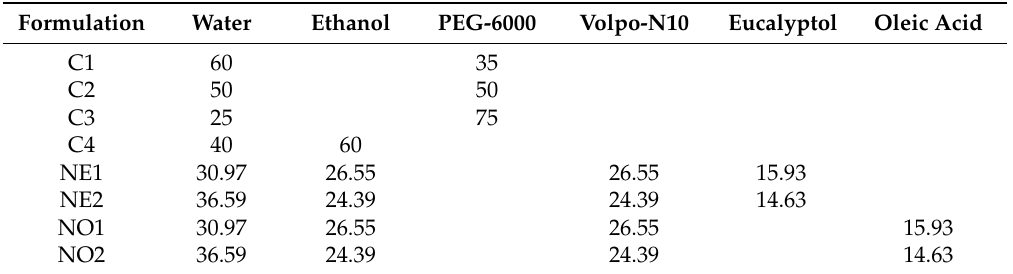
Table 1. Compositions (% w / w ) of control solutions (C1–C4) and nanoemulsion formulations with penetration enhancers eucalyptol (NE1 and NE2) and oleic acid (NO1 and NO2). The concentration of minoxidil in aqueous controls and nanoemulsions was 2% w / w , except in C1, which was a saturated solution.